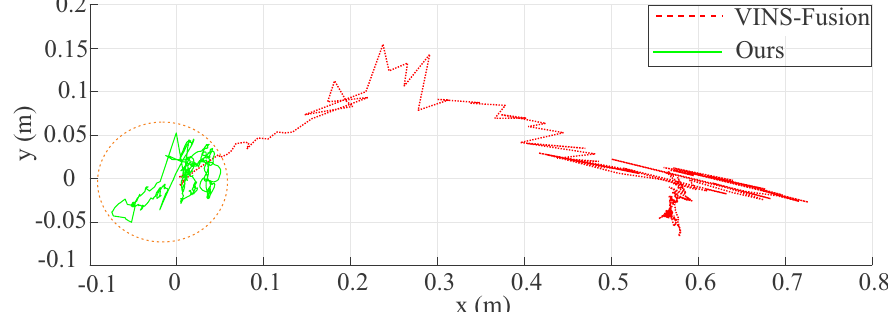
Figure 13. The estimated trajectory (blue line) drifts over time compared with VINS-Fusion [13] (red dash line) in a very high dynamic